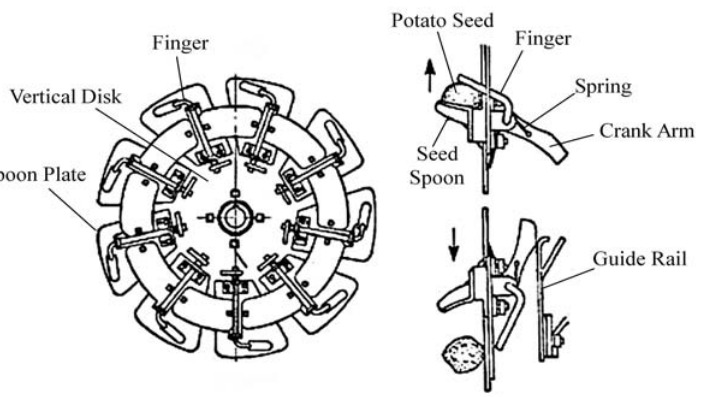
Figure 10. Pickup finger seed metering device. Reprinted with permission from ref. [31]. Copyright 2019 Chinese Society for Agricultural Machinery.